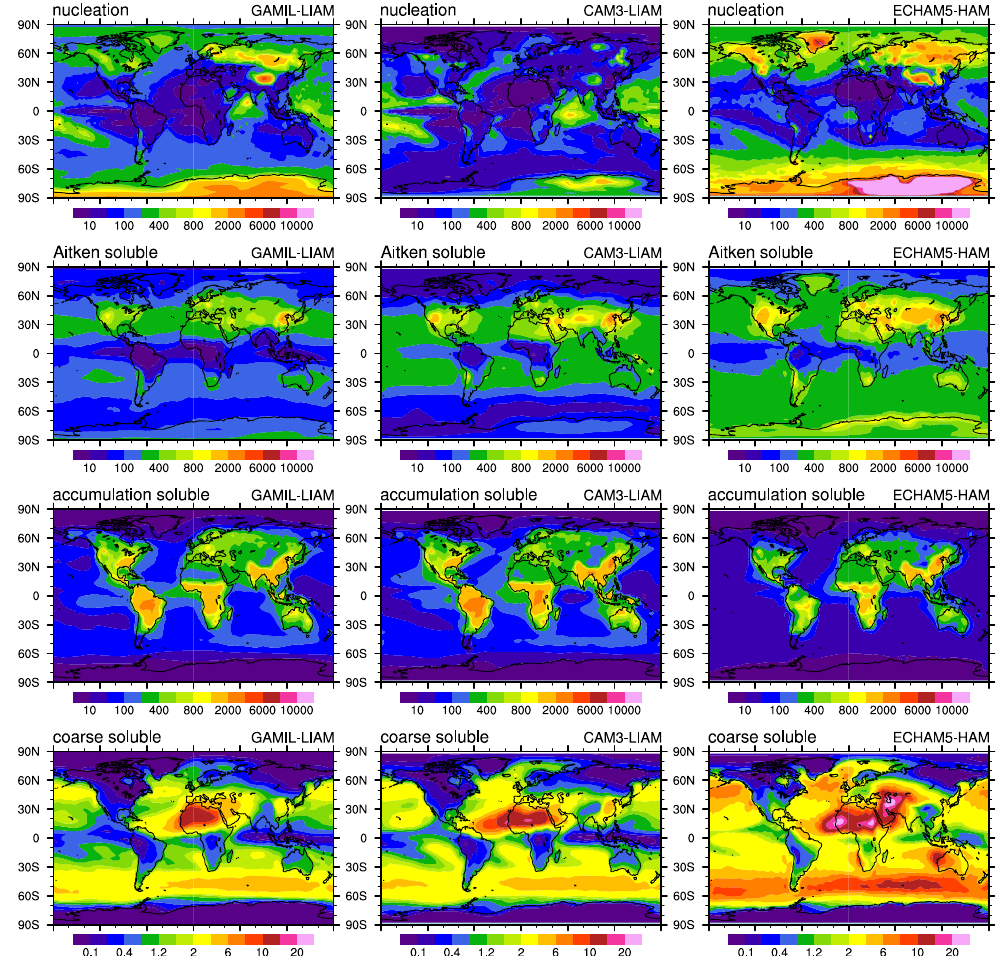
Fig. 3. Annual mean aerosol number concentration of the four soluble modes (from top to bottom) at the lowest model level simulated by GAMIL-LIAM (left column), CAM3-LIAM (middle column) and ECHAM5-HAM (right column). The unit is number of particles per cubic centimeter at the standard atmospheric state (1013.25 hPa, 273.15 K).